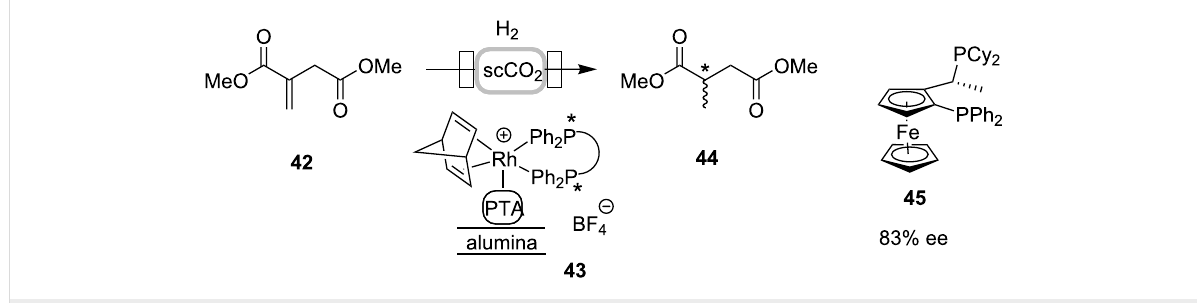
Scheme 12: Continuous asymmetric hydrogenation of dimethyl itaconate in scCO 2 .